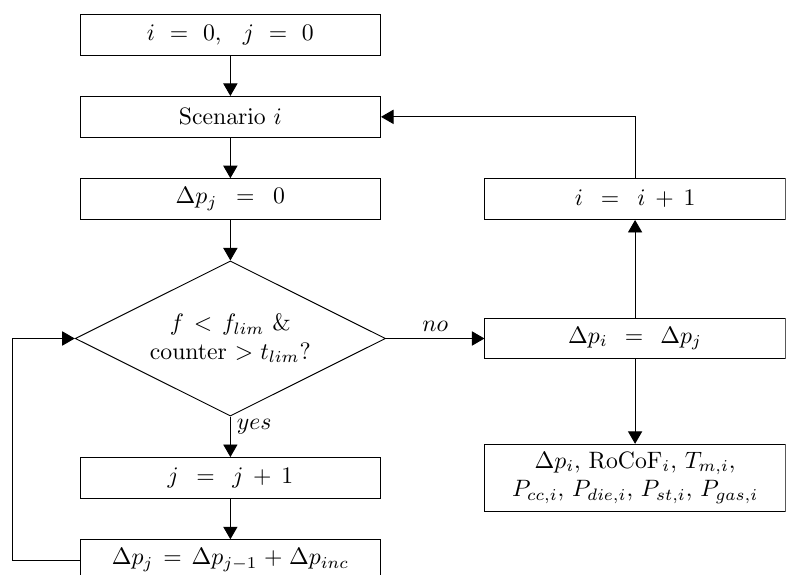
Figure 5. Flow-chart to estimate the overproduction of VSWTs.